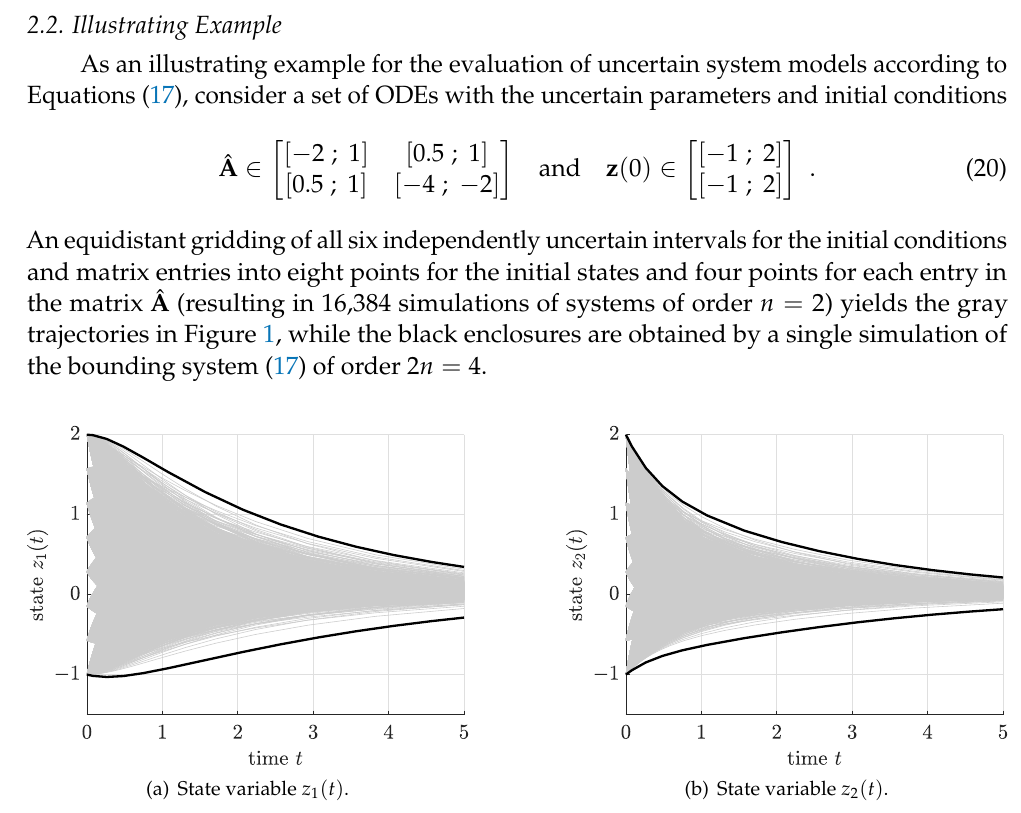
Figure 1. State enclosures by means of exploiting cooperativity for the simple benchmark system in